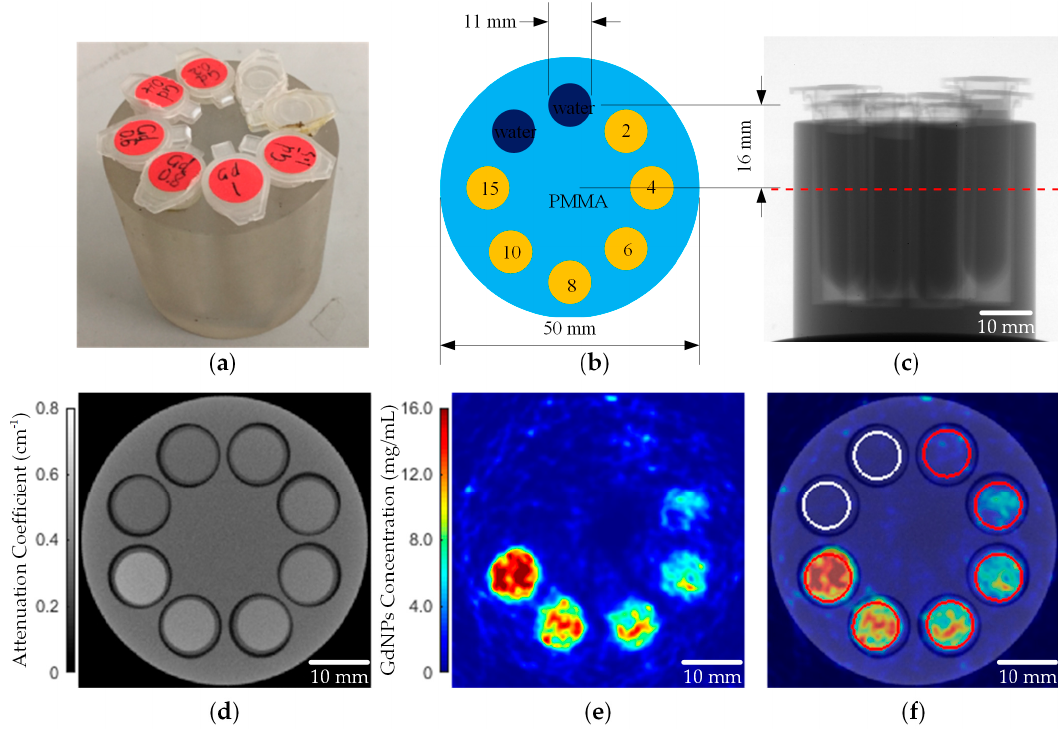
Figure 1. ( a ) The phantom used for concentration calibration; ( b ) The gadolinium (Gd) concentration (mg/mL) of each insertion; ( c ) An x-ray transmission image of the phantom (the red line denotes the axial slice used for the x-ray fluorescence computed tomography (XFCT) scan); ( d ) Reconstructed transmission computed tomography (CT) image; ( e ) Reconstructed XFCT image; ( f ) The CT and XFCT fused image (the red circles denote the sampling points of each insertion and the white circles denote the sampling points of the background).